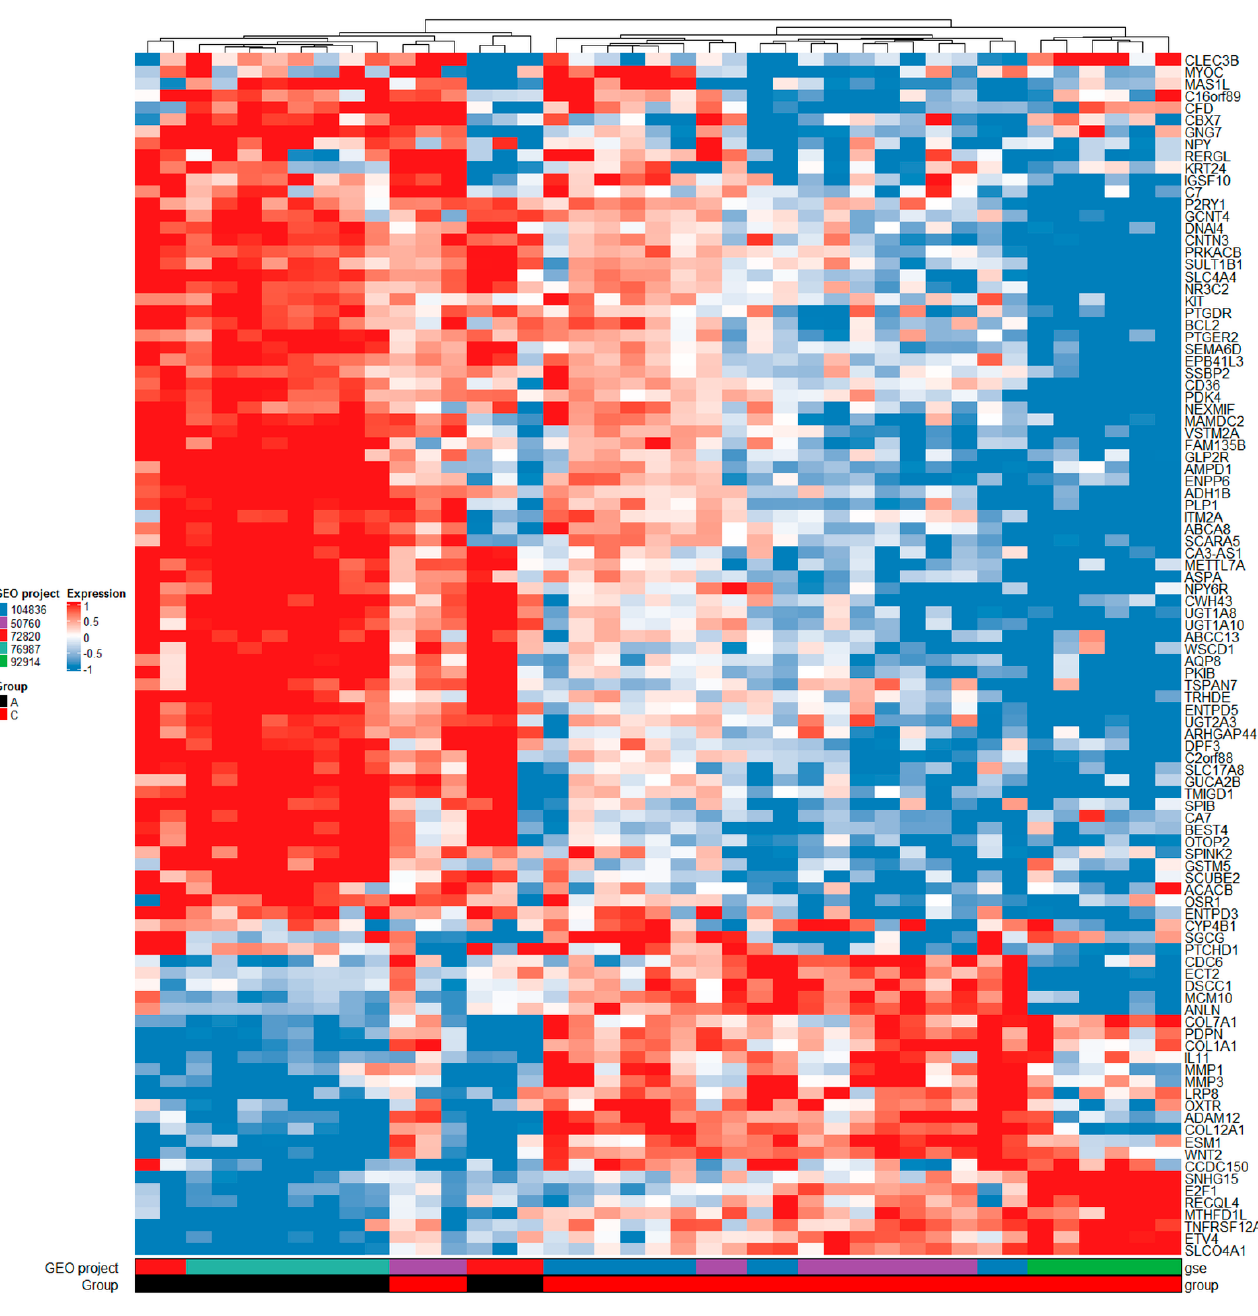
Figure 3. Heatmap of top 100 DEGs between adenomas and carcinomas. Legend: GEO, gene expression omnibus; GSE, gene expression omnibus series; group A, adenoma; group C, carcinoma tissue; gene names are shown on the right side of the heatmap; downregulation is associated with blue color, no difference in expression is associated with white color, and upregulation is associated with red color.